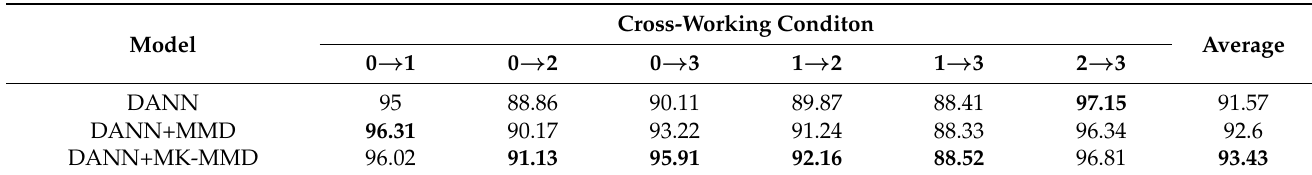
Table 5. Classification accuracy of models using distance for domain adaptation in cross-working conditions.